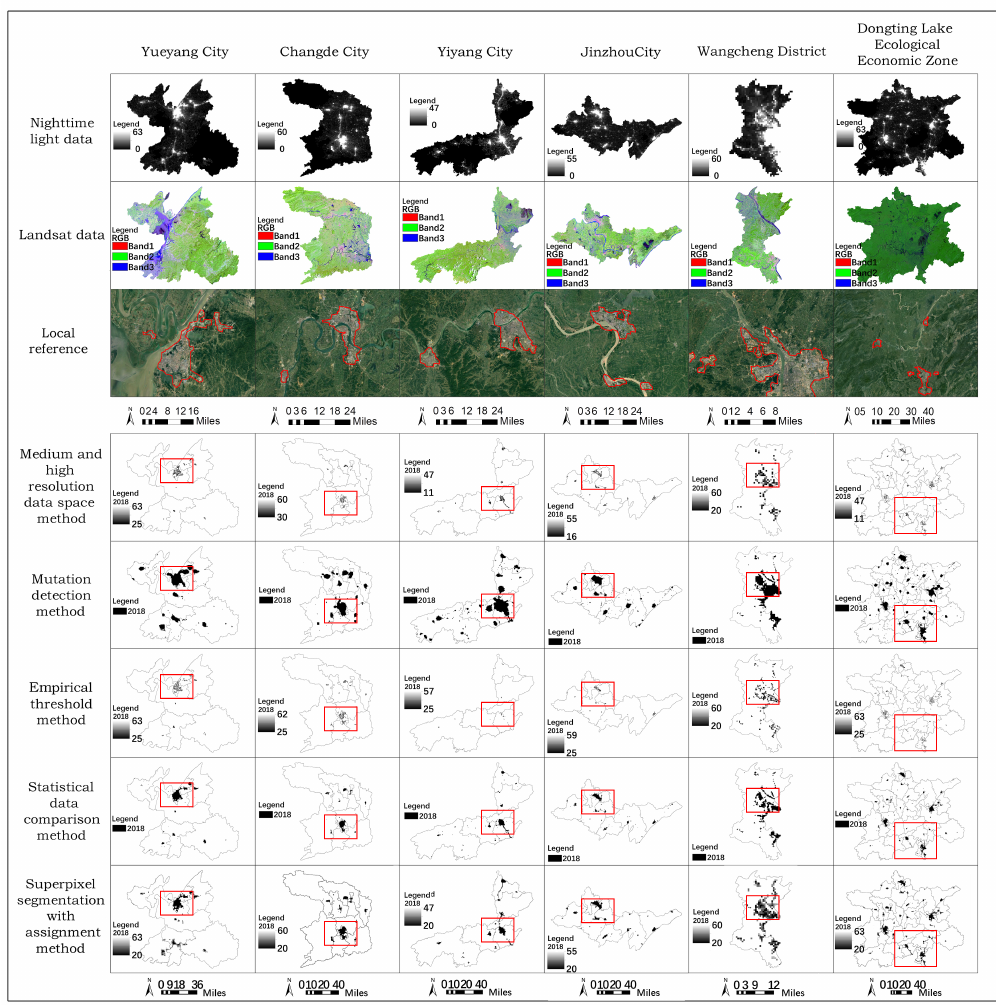
Figure 7. Extraction results comparison.